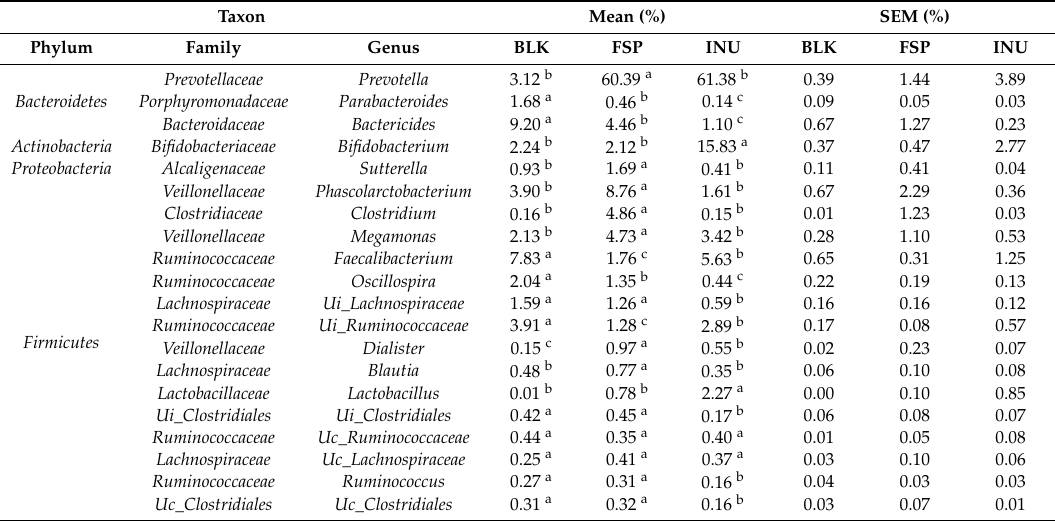
Figure 4. Compositions of gut microbiota. ( a ) Alpha diversity analysis of Simpson index and Shannon index, ( b ) Bray–Curtis clustering analysis, ( c ) principal component analysis of gut microbiota at the OTU level, ( d ) taxonomic composition distribution at the phylum level. Table 4. Composition of the top 20 taxons identified in the tested groups at genus